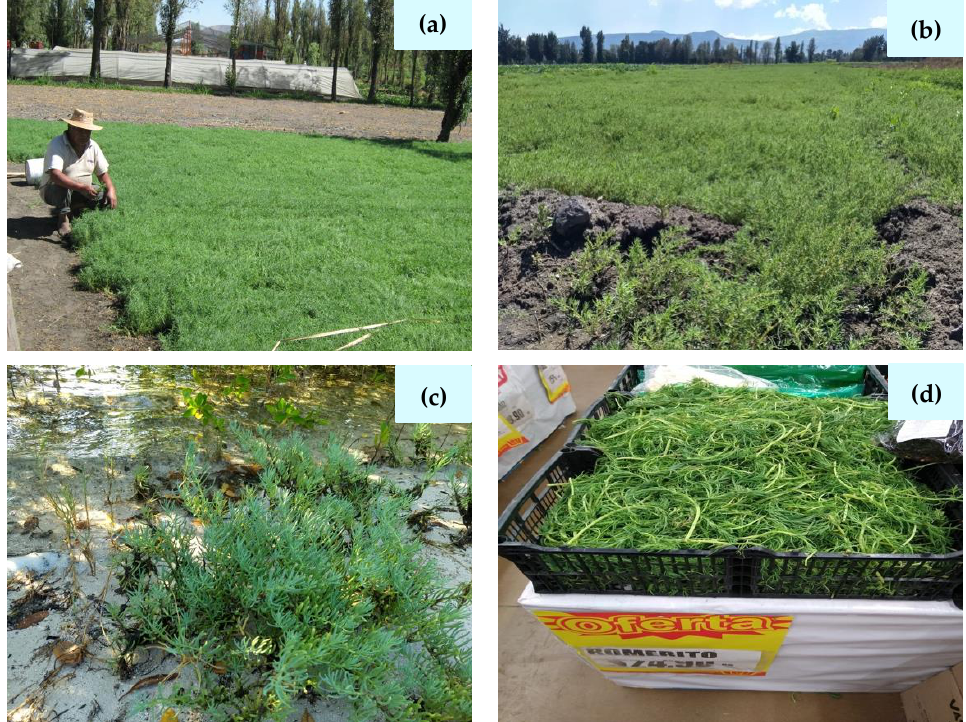
Figure 1. Photographs of Suaeda spp. ( a ) Suaeda edulis in an agricultural plot supervised by the owner; ( b ) panoramic view of a Suaeda edulis plot in the State of Mexico; ( c ) Suaeda esteroa on the coast of the Sea of Cortes in Baja California Sur, NW México; ( d ) Suaeda edulis ‘Romerito’ in a food market in the State of Sonora, Mexico. Photographs ( a , b ) were given and authorized by Dr. Roberto Noguez Hernández (Chapingo Autonomous University), Chapingo, Edo. Méx, México.